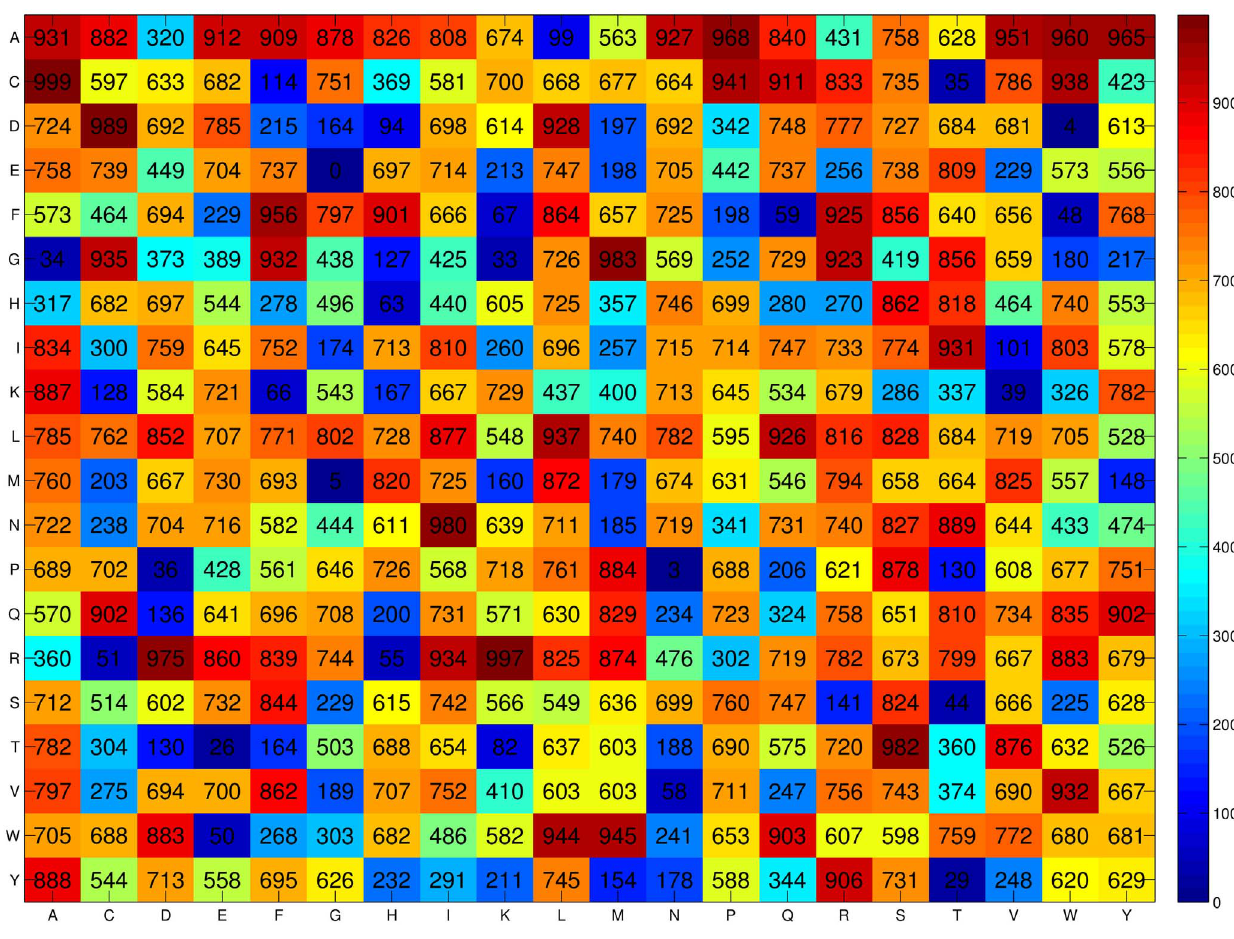
Figure 6. Heat map of the propensity scores of 400 dipeptides obtained from the SCMLFP method. Color bar is obtained using Jet of Matlab.